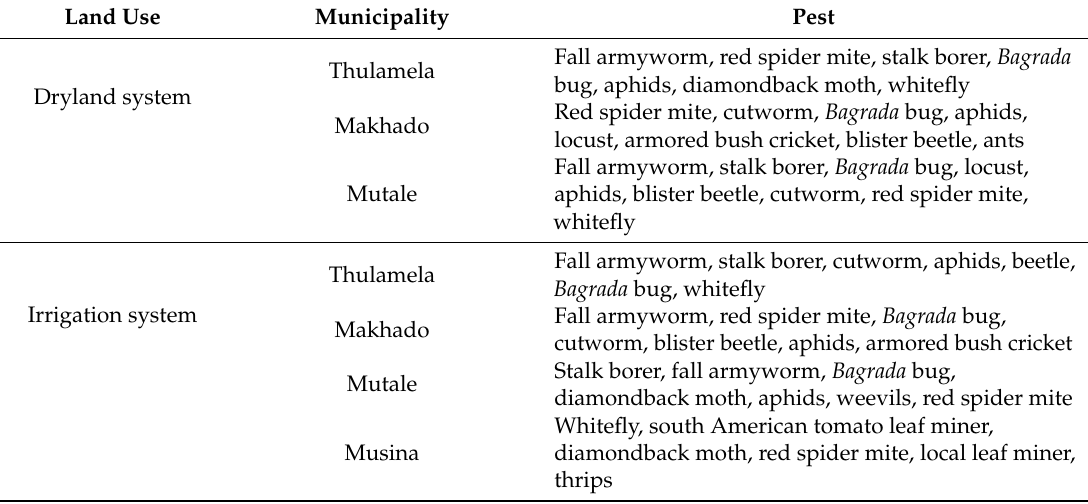
Table 5. Perception of the problematic insect pests across municipalities mentioned in a Focus Group Discussions.